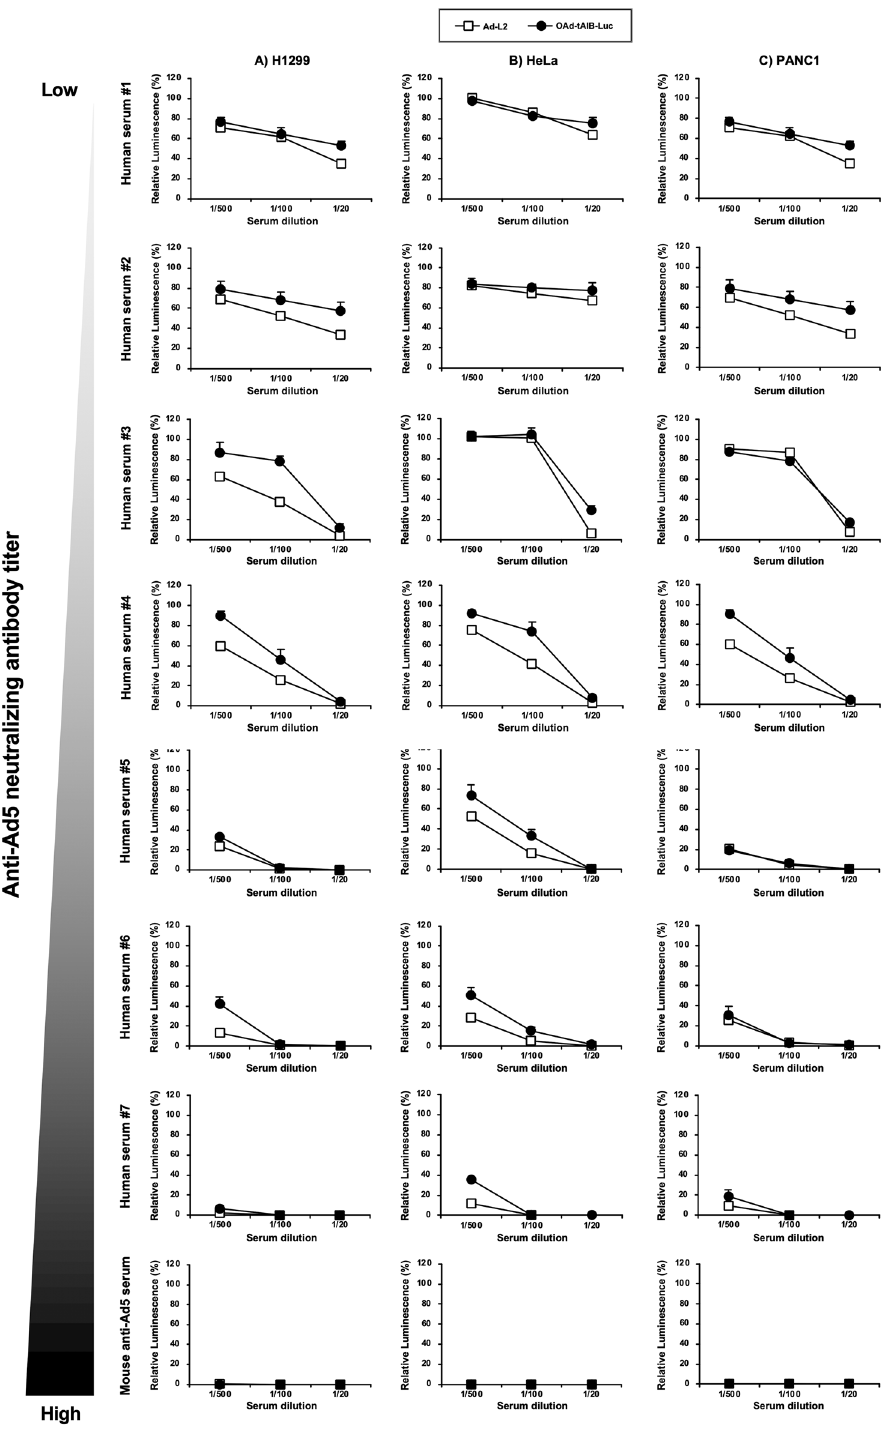
Figure 1. In vitro luciferase expression of Ad-L2 and OAd-tAIB-Luc in the presence of mouse and human serum. Ad-L2 and OAd-tAIB-Luc were pre-incubated with diluted mouse and human serum followed by adding to ( A ) H1299, ( B ) HeLa, and ( C ) PANC-1 cells at 200 VP/cell. Luciferase activities were measured 3 days after virus treatment. The luminescence levels in the cells without pre-incubation with human serum were normalized to 100%. These data are expressed as the means ± S.D. (n =